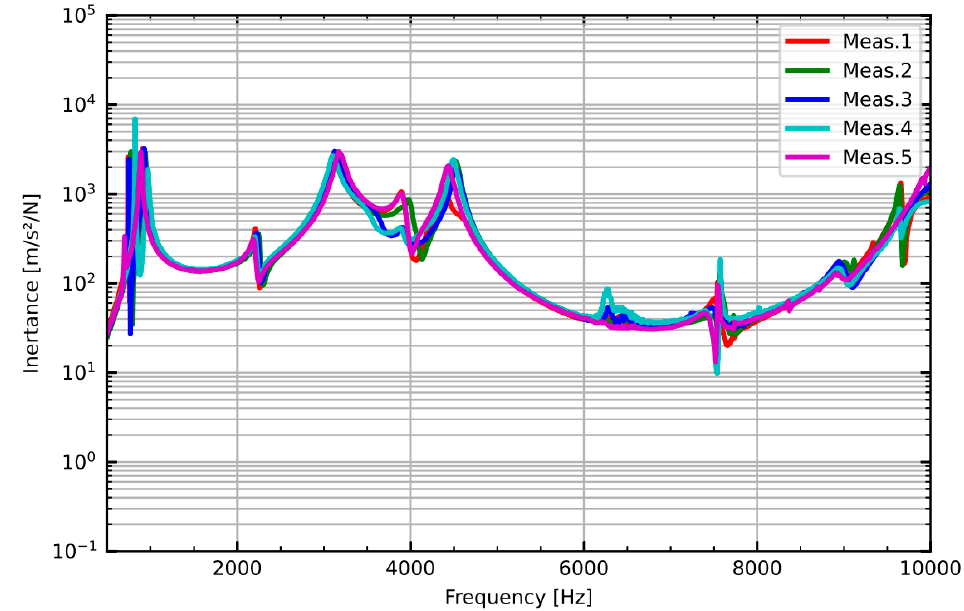
Figure 5. Repeatability for one transmission fluid; repeated five times.